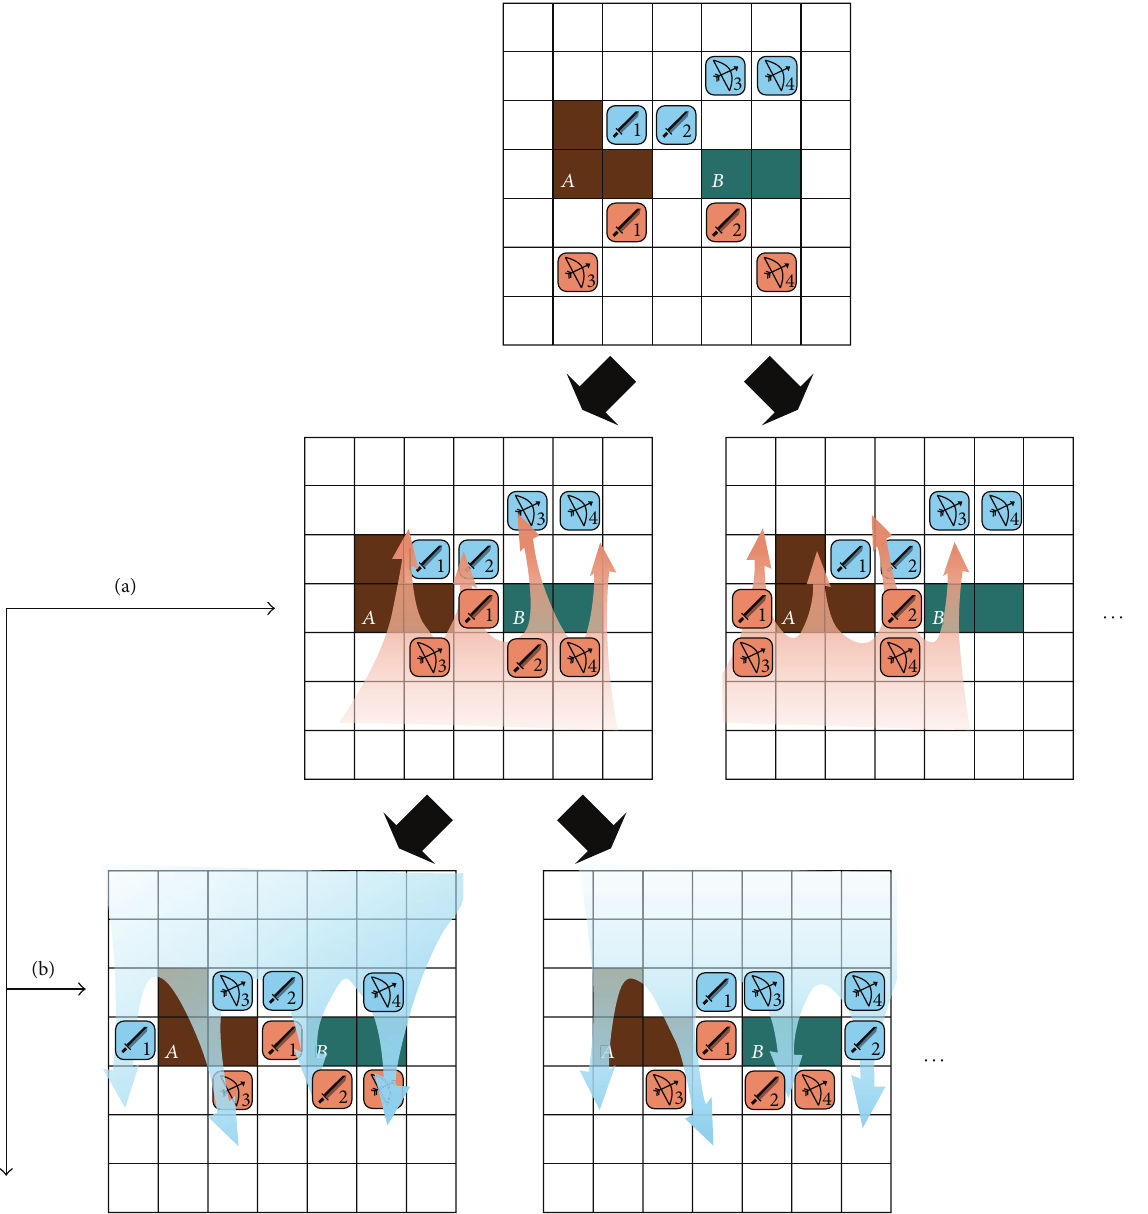
Figure 9: Search tree of TBW game: (a) red side’s turn; (b) blue side’s